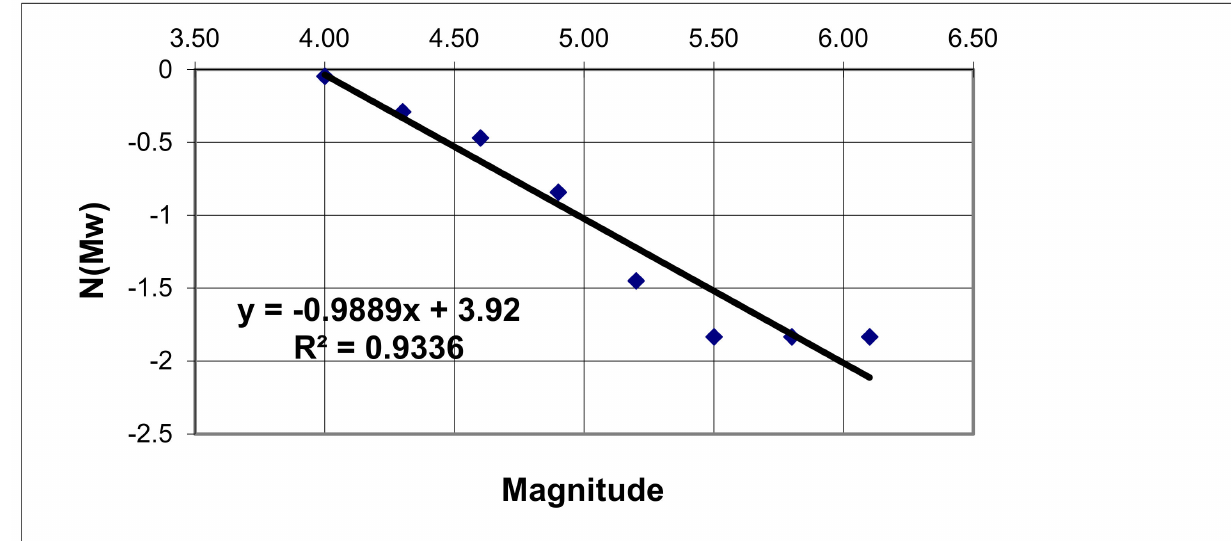
Figure 6. Gutenberg–Richter recurrence relationship curve for source zone 1.